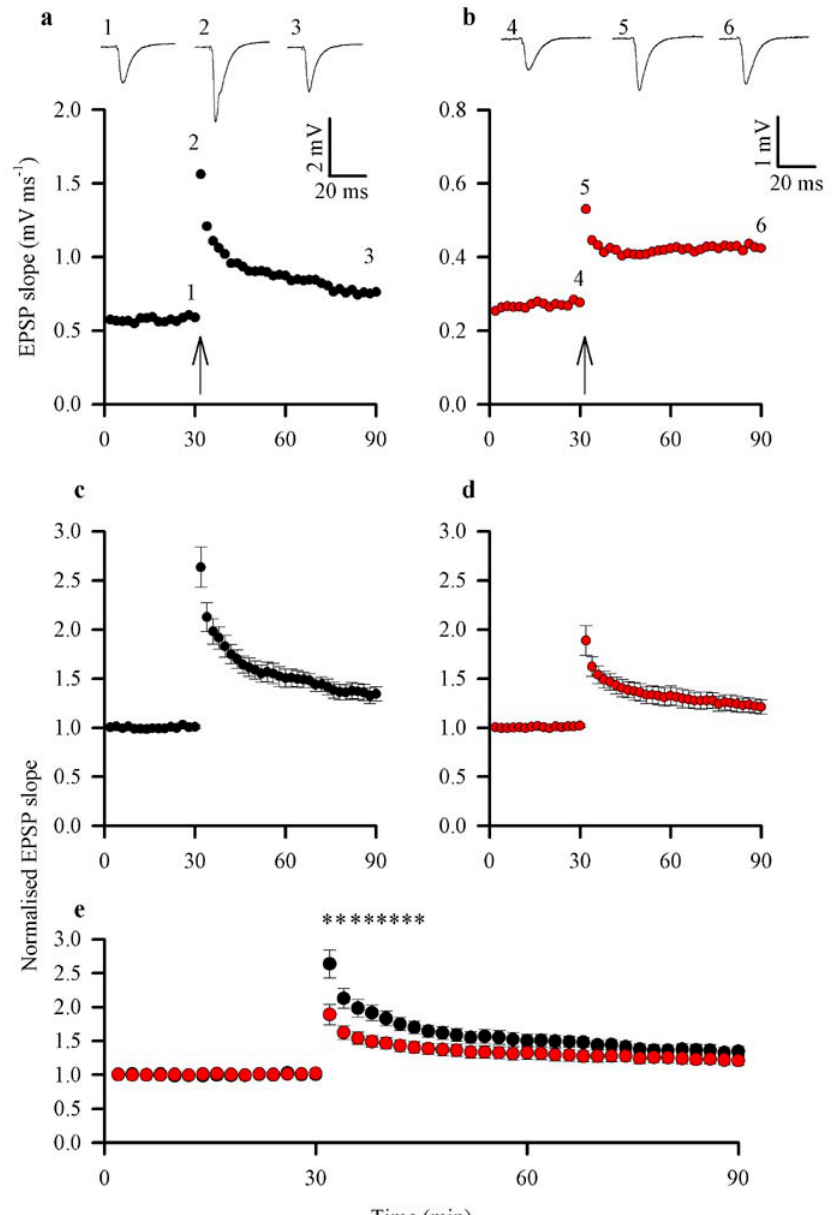
FIGURE 1. STP is reduced in mGlu7 knockout mice. Representative examples of individual experiments are shown for wildtype (a) and mGlu7 knockout (b) mice. The corresponding pooled data for 14 slices from wildtype (c) and 12 slices from mGlu7 knockout (d) mice are superimposed (e) to illustrate the extent of the deficit in